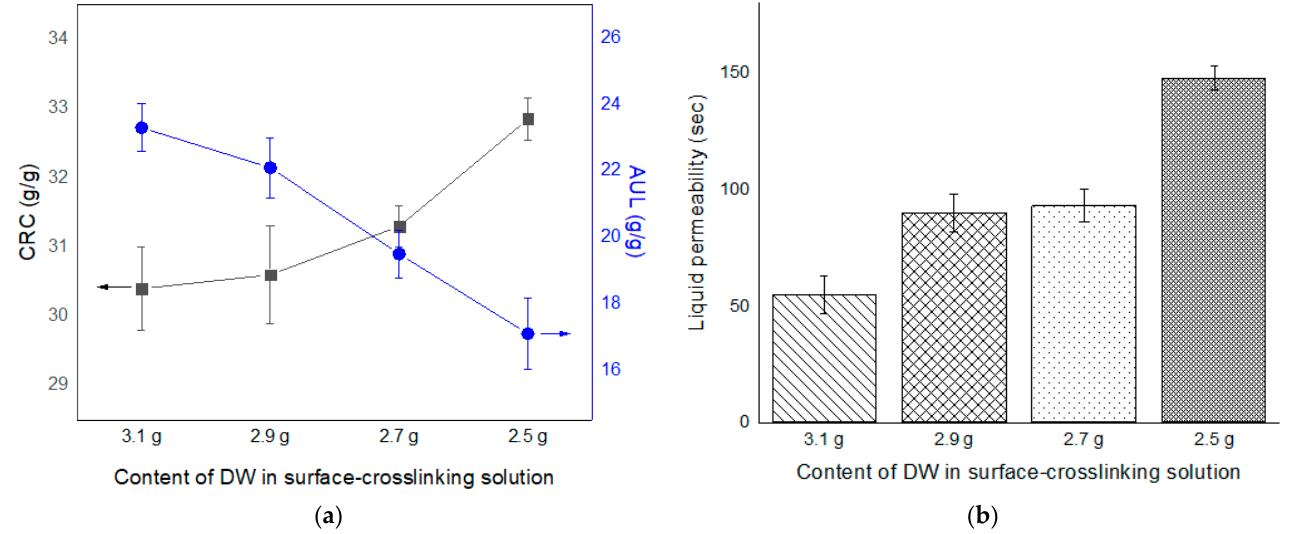
Figure 7. The CRC and AUL ( a ) and permeability ( b ) of the SSAP according to content of DW in surface-crosslinking solution.